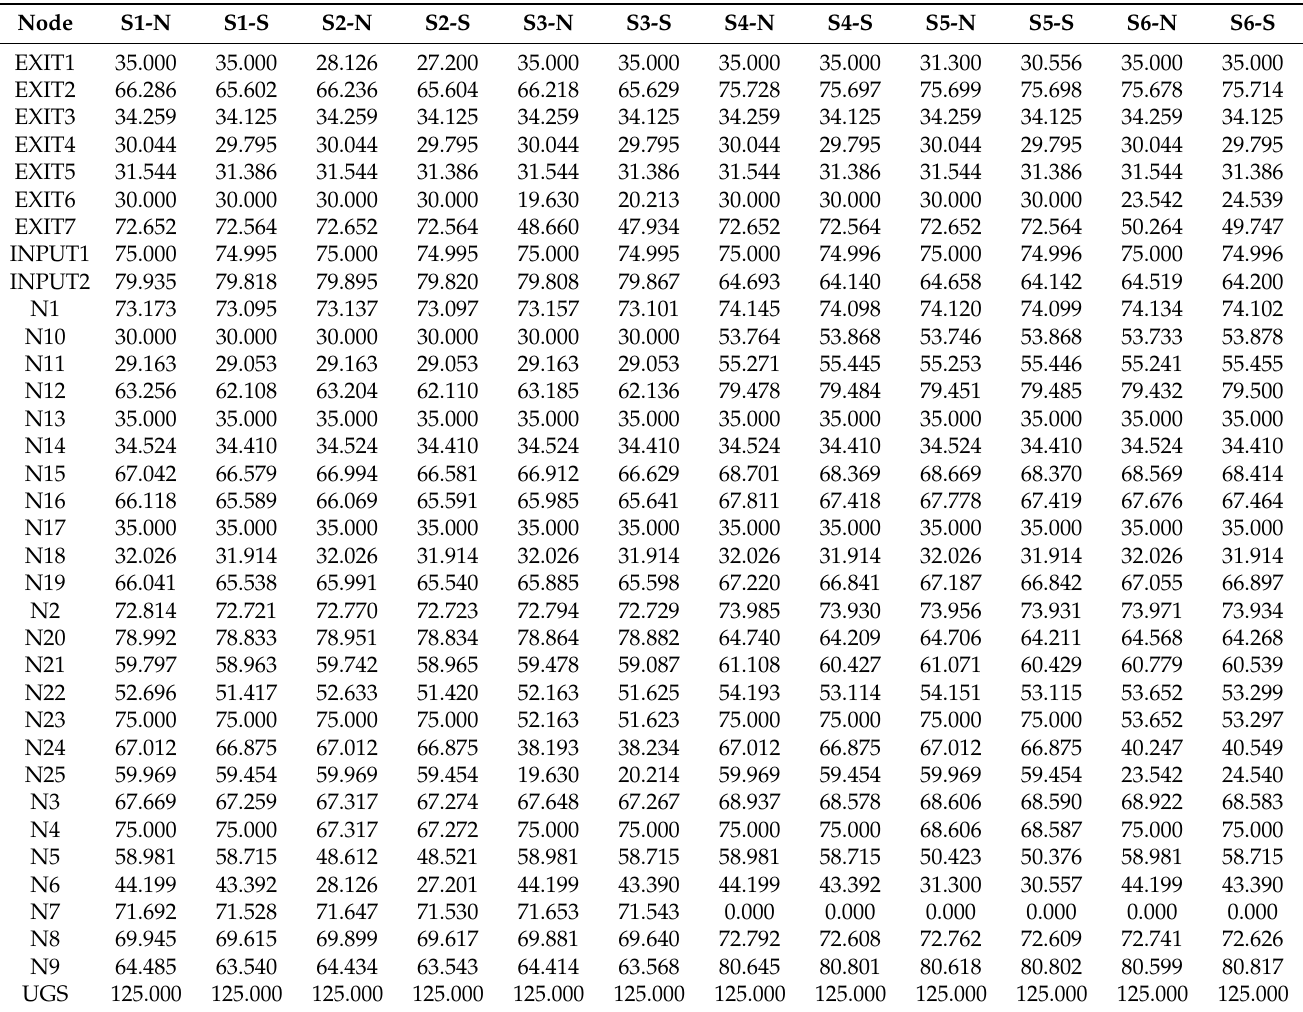
Table 5. Results of simulation in case study 1—gas pressures